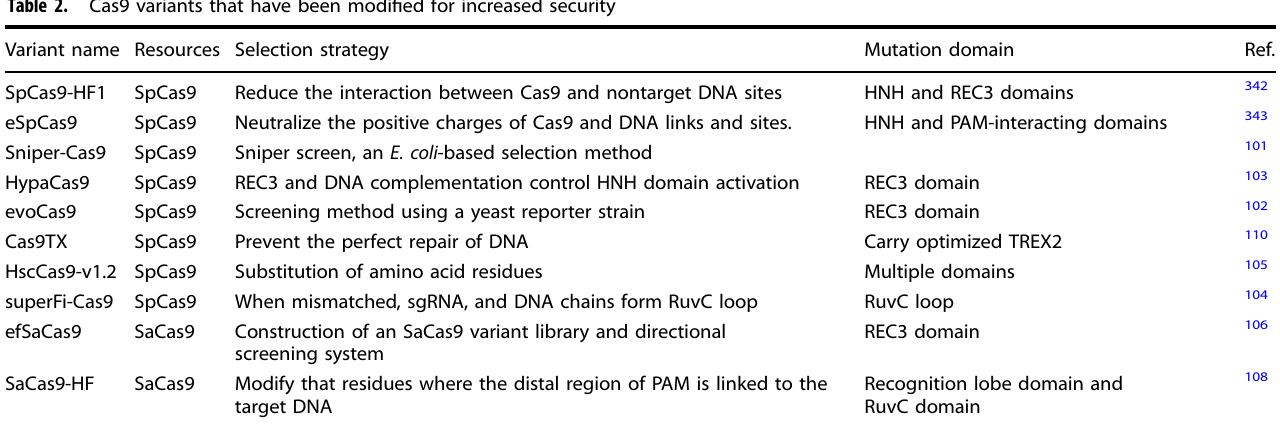
Table 2. Cas9 variants that have been modi fi ed for increased